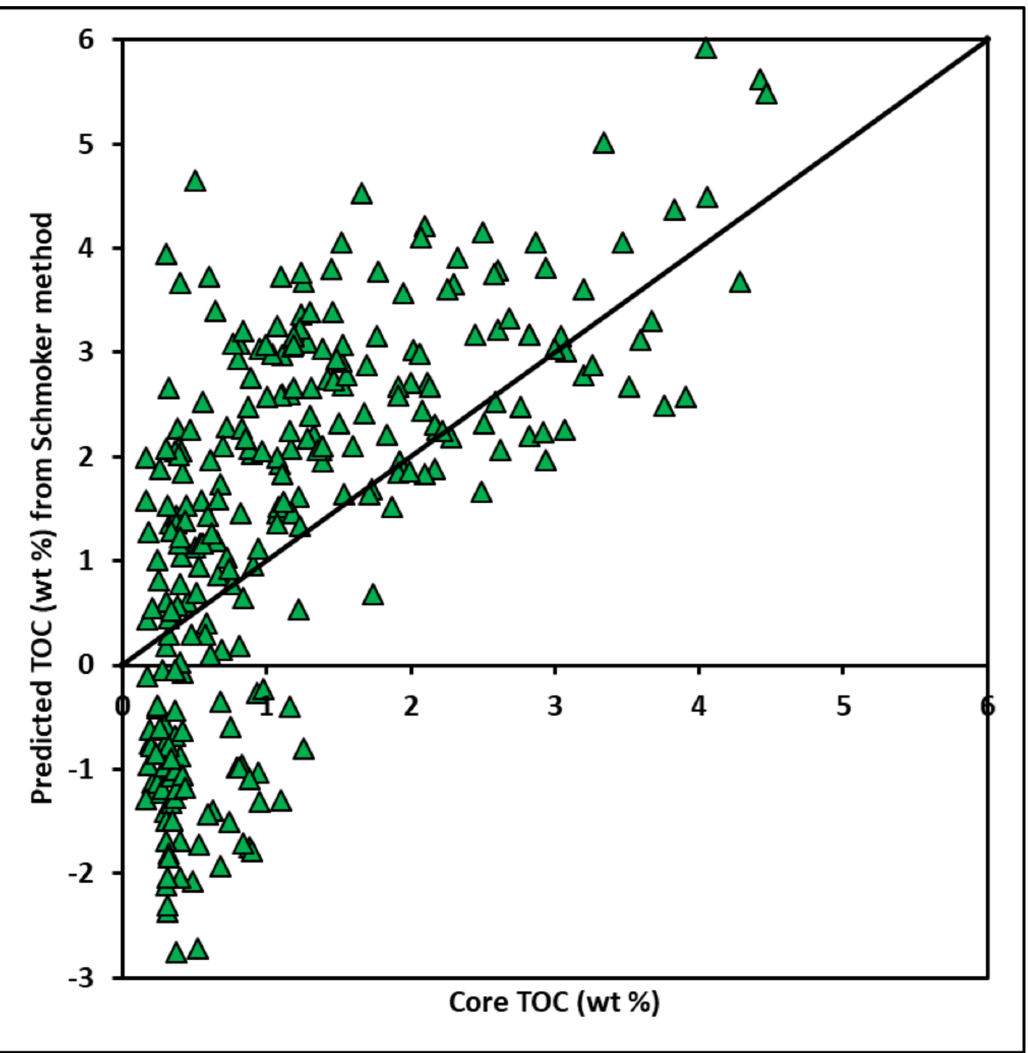
Figure 11. Cross ‐ plot of core TOC from Rock ‐ Eval pyrolysis of core specimen and Schmoker’s method derive TOC. The black line is a 1:1 ratio between input and output variables. MSE and R 2 values are 2.037 and 0.43, respectively.